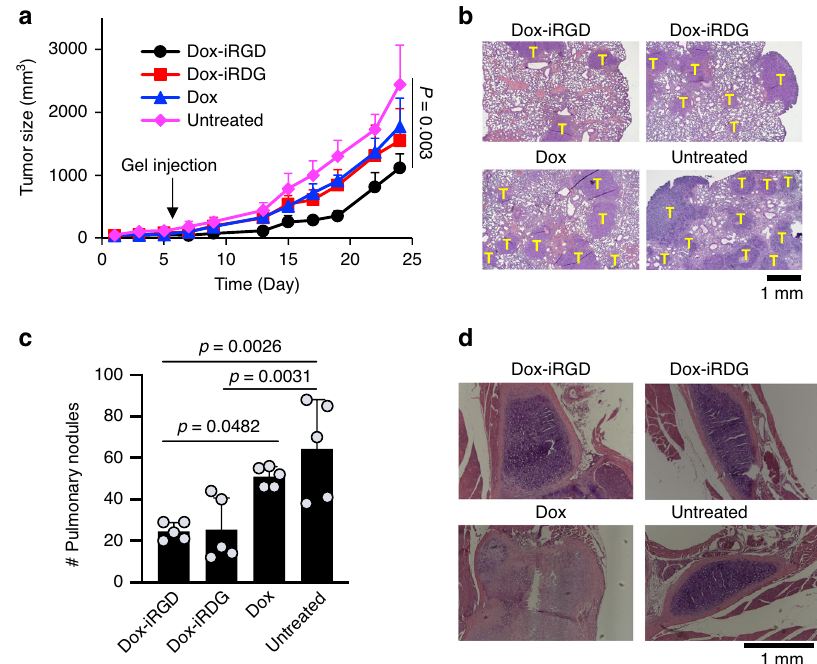
Fig. 3 Pore-forming alginate gels containing Dox-iRGD and GM-CSF delay 4T1 tumor growth and reduce metastases. Gels were peritumorally injected when the tumors grew to ~6 – 7 mm. GM-CSF was incorporated in all gels. Mice without gel treatment were used as controls. a Average 4T1 tumor volume of each group over the course of the ef fi cacy study. n = 5 biologically independent animals per group. Statistical analysis was performed using ANOVA with Fisher ’ s LSD post hoc test. b Representative images of H&E-stained lung tissues collected at 18 days post peritumoral injection of gels containing Dox- iRGD, Dox-iRDG, and Dox, respectively. T indicates tumors. c Average tumor nodule counts on the lung tissues at 18 days post gel injection. n = 5 biologically independent animals per group. Statistical analysis was performed using ANOVA with Fisher ’ s LSD post hoc test. d Histopathology of spinal bone marrow tissues collected at 18 days post gel treatment. Scale bar: 1 mm. For b and d , experiments were repeated once. All the numerical data are presented as mean ± SD, except for a where mean ± SEM is used. Source data are provided as a Source Data fi